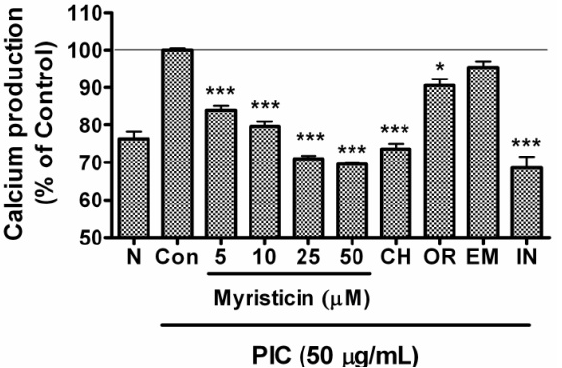
Figure 5. Effects of myristicin on calcium production in dsRNA-stimulated RAW 264.7 mouse macrophages. Intracellular production of calcium after 24 h treatment was measured with Fluo-4 calcium assay. Normal group (N) was treated with media only. Control group (Con) was treated with PIC (the synthetic analog of dsRNA, 50 µg/mL of polyinosinic- polycytidylic acid) alone. As reference materials, chrysin (CH), oroxylin A (OR), and emodin (EM) were treated at the concentration of 25 µM. IN denotes indomethacin (0.5 µM). Values are the mean ± SEM of three independent